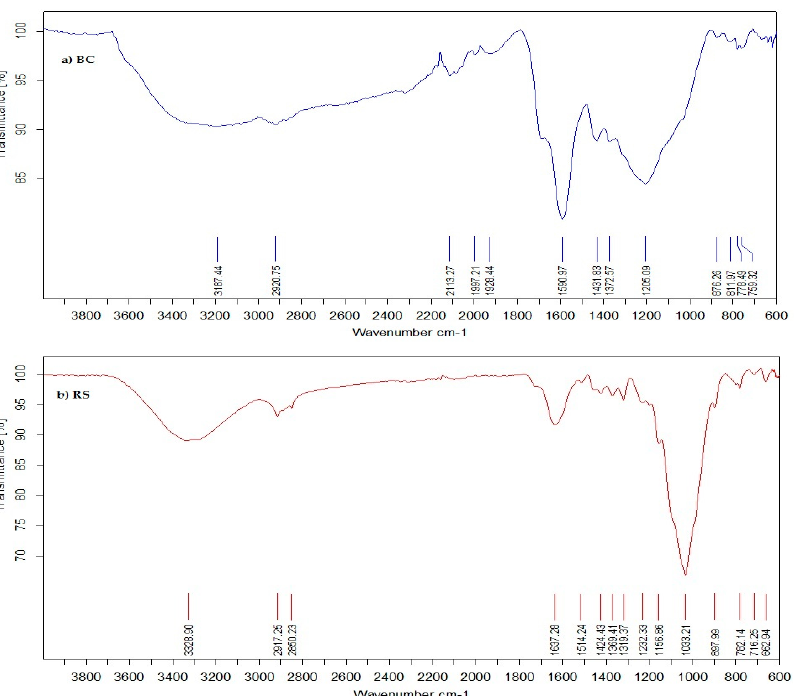
Figure 1. Fourier transform infrared (FTIR) spectra of the biochar (BC) ( a ) and rice straw (RS) ( b ) used in the experiments.